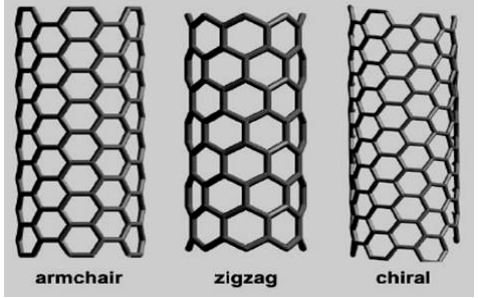
Figure 2. Carbon nanotube (CNT) models.